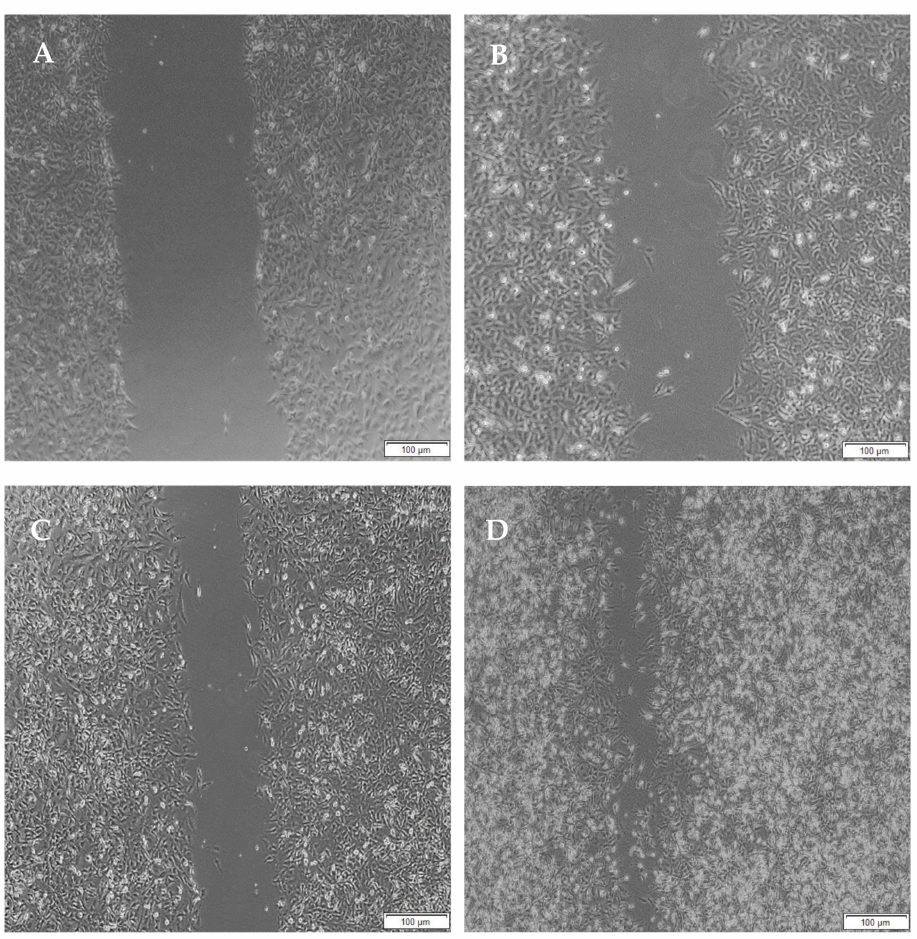
Figure 17. Micrographs of the migration of A172 cells from a wound-healing assay of the untreated at ( A ) 0 h, ( B ) 8 h, ( C ) 24 h and ( D ) 48 h. Images were captured using the 4 × objective and the phase contrast feature of an inverted light microscope. The red arrows indicate actively migrating cells at 8